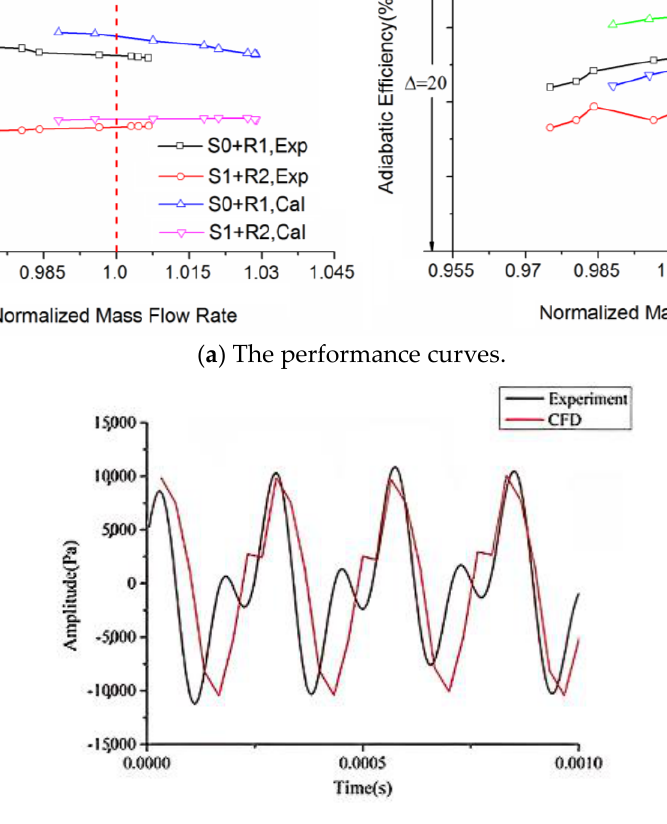
Figure 4. The comparison between the CFD and experiment .